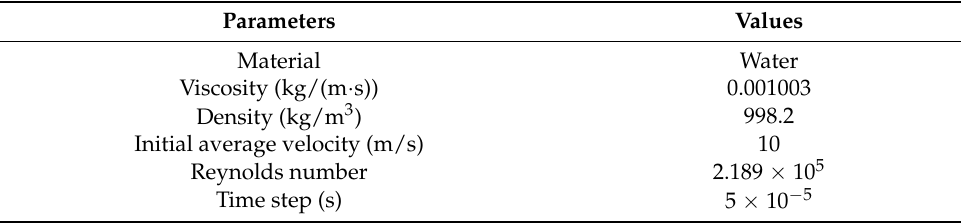
Table 2. Parameters of the liquid phase in